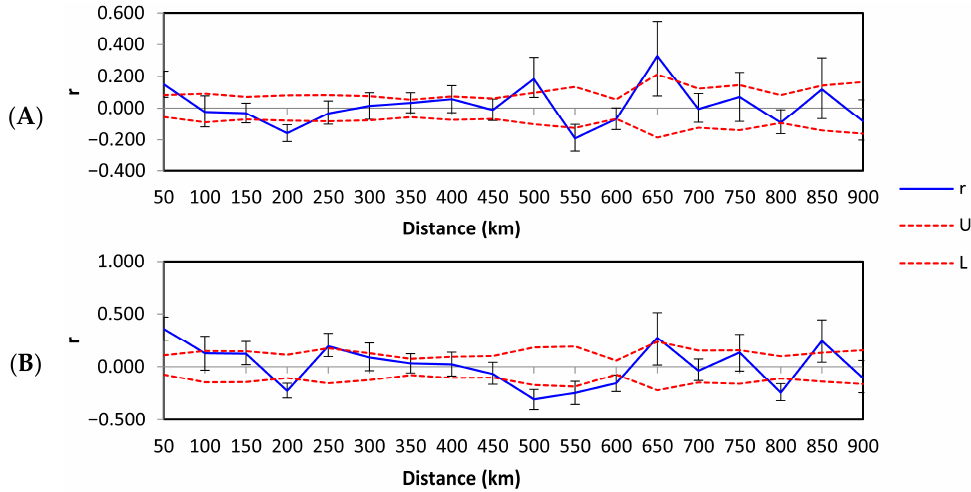
Figure 4. Spatial autocorrelograms of the genetic correlation coefficient (r) as a function of distance for Beauveria pseudobassiana across northern European Russia ( A ) for all haplotypes and ( B ) for all haplotypes with the exception of T1B1.1 and T2B1.1 (the most abundant) haplotypes in the dfc climate zone. Dashed lines represent the upper (U) and lower (L) bounds of the 95% confidence intervals about the null hypothesis of random distribution of haplotypes; error bars are bootstrapped 95% confidence intervals within each distance class.